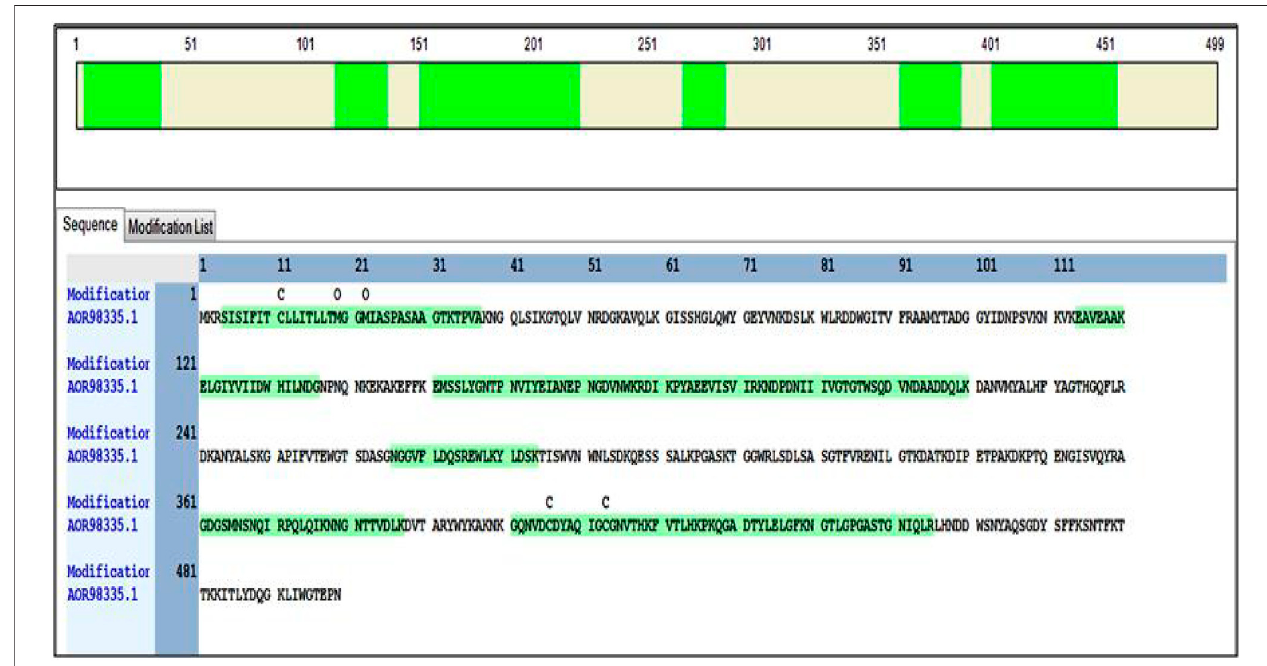
FIGURE 3 | The green highlighted portion in the fi gure represents the amino acid sequence present in the protein of interest (cellulase) that hit the sequence of the master protein at different regions.